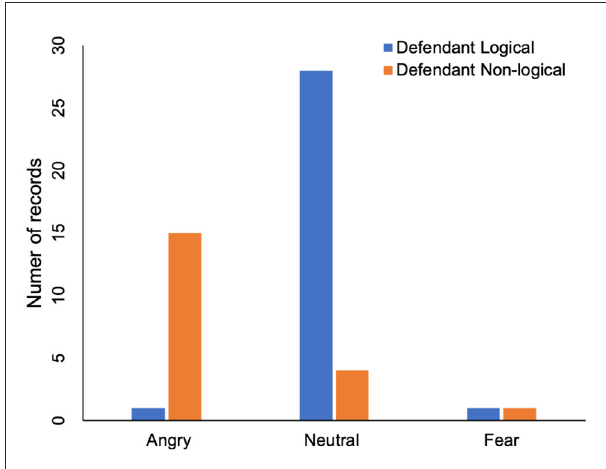
FIGURE4 The influence of voice at court on defendant’s